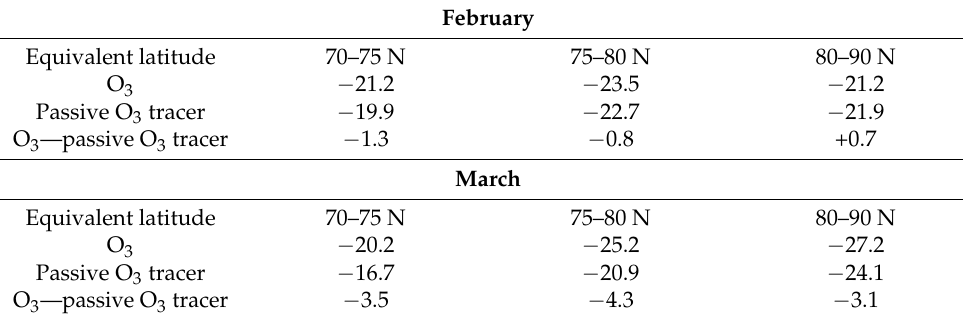
Table 3. Total ozone anomaly (DU) for the QBO-W/S min years.